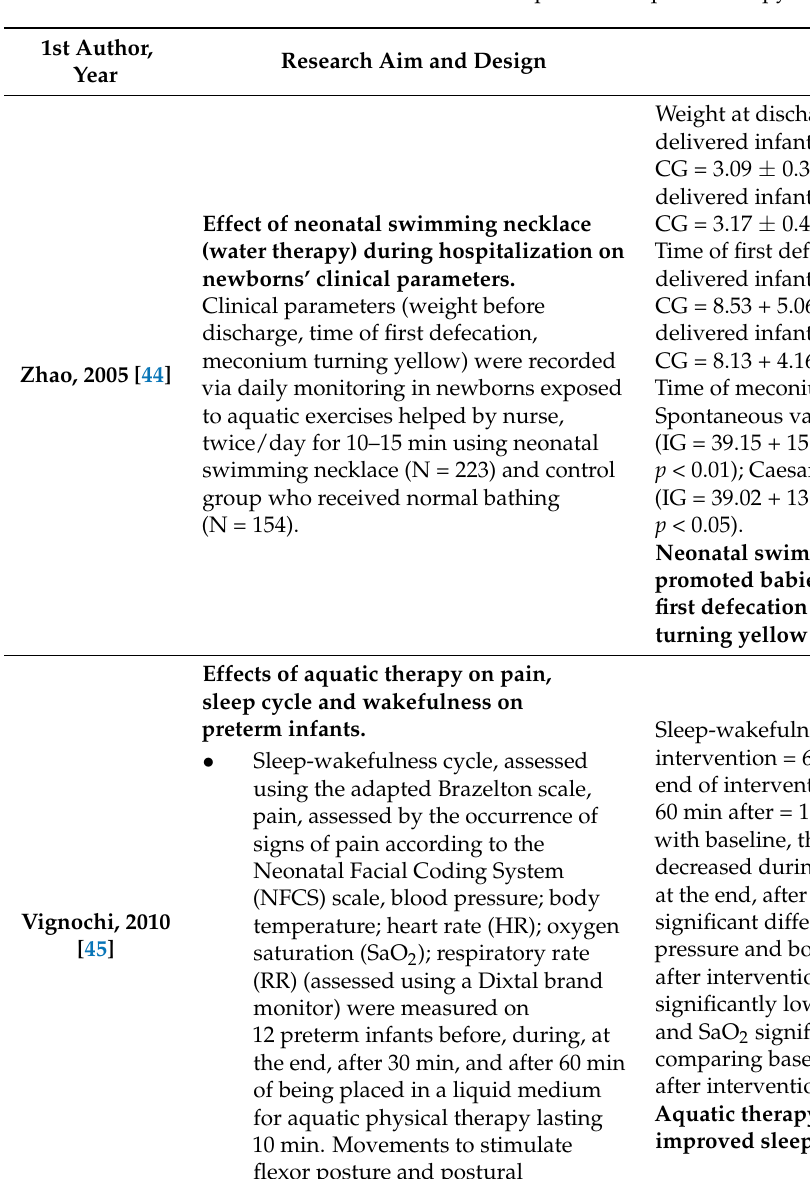
Table 4. Effects of exposure to aquatic therapy on infants’ health and physiological